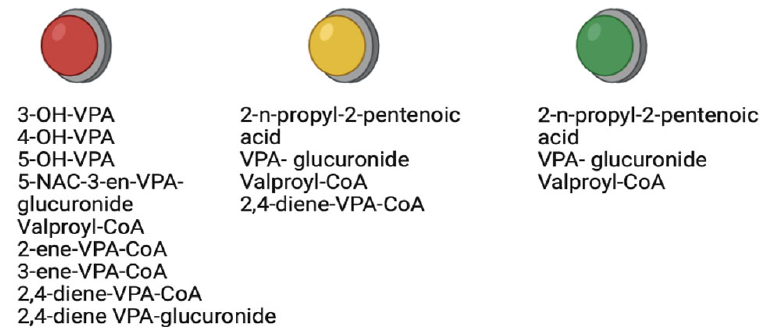
Figure 5. Clinical classification of valproic acid metabolites: green sign–therapeutic metabolites; yellow sign–neutral metabolites; red sign–toxic metabolites.